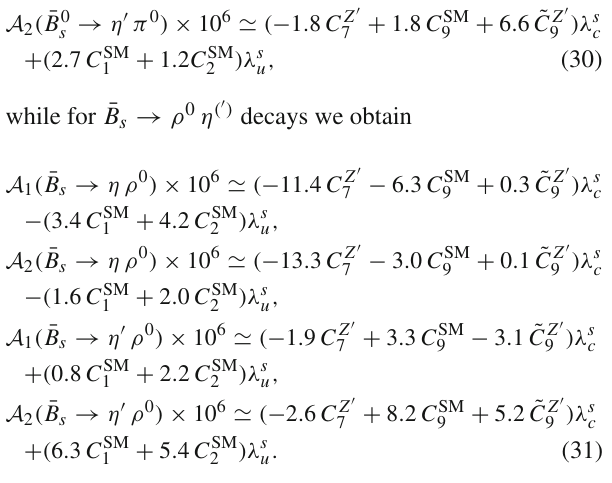
Fig. 3 Left ( right ): contours of R M